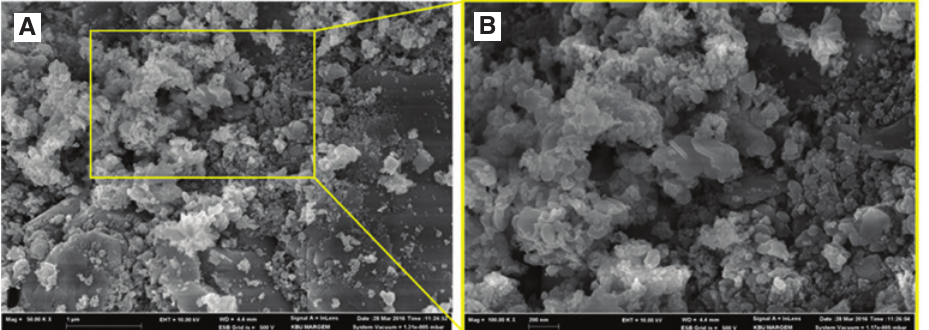
Figure 4: Field emission-scanning electron microscopy (FE-SEM) images of zinc oxide nanoparticles (ZnO-NPs): (A) GS and (B) enlarged GS samples.